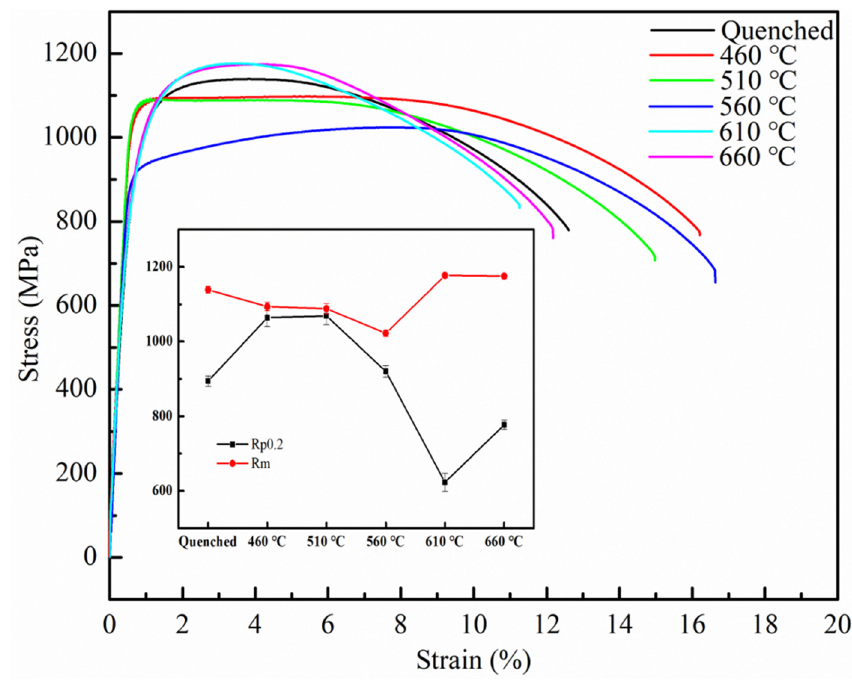
Figure 4. Tensile property changes of Fe-9Ni-2Cu steel with the increase of temperatures.